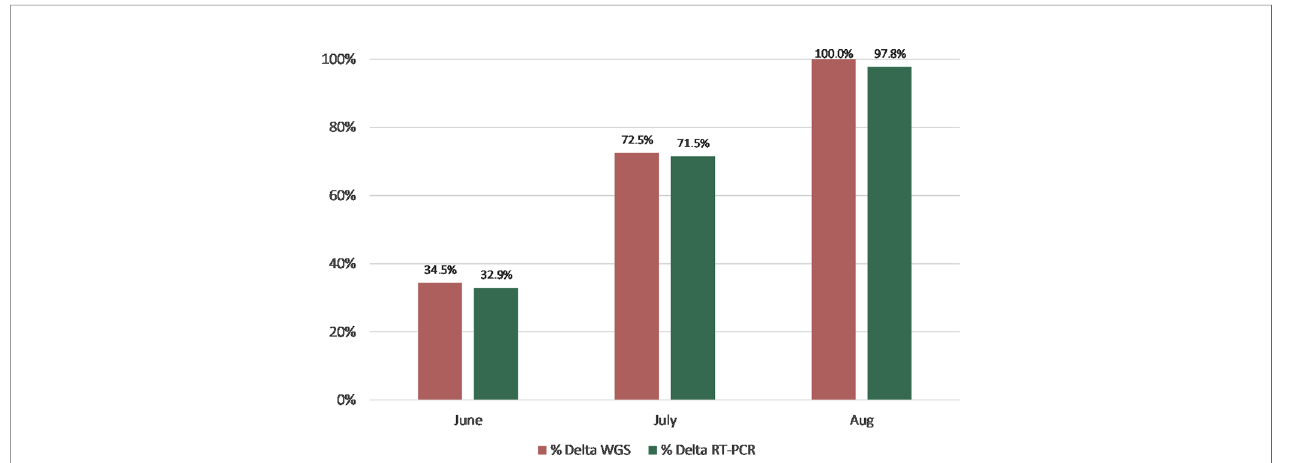
FIGURE 1 | Prevalence of the Delta lineage (June-August 2021) by WGS vs. RT-PCR genotyping (N= 664). The differences in the Delta lineage proportions between WGS and RT-PCR were not statistically signi fi cant (Fisher Exact test).